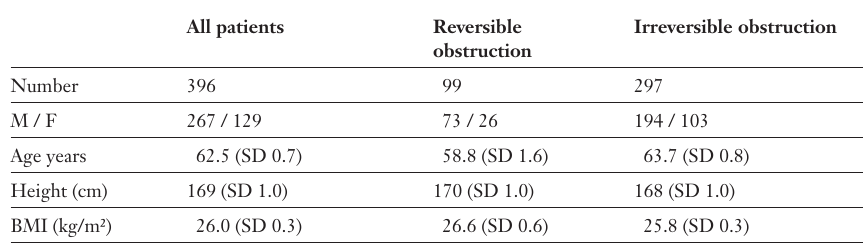
Sex, age, height and body mass index (BMI) in patients with reversible and irre- versible airway